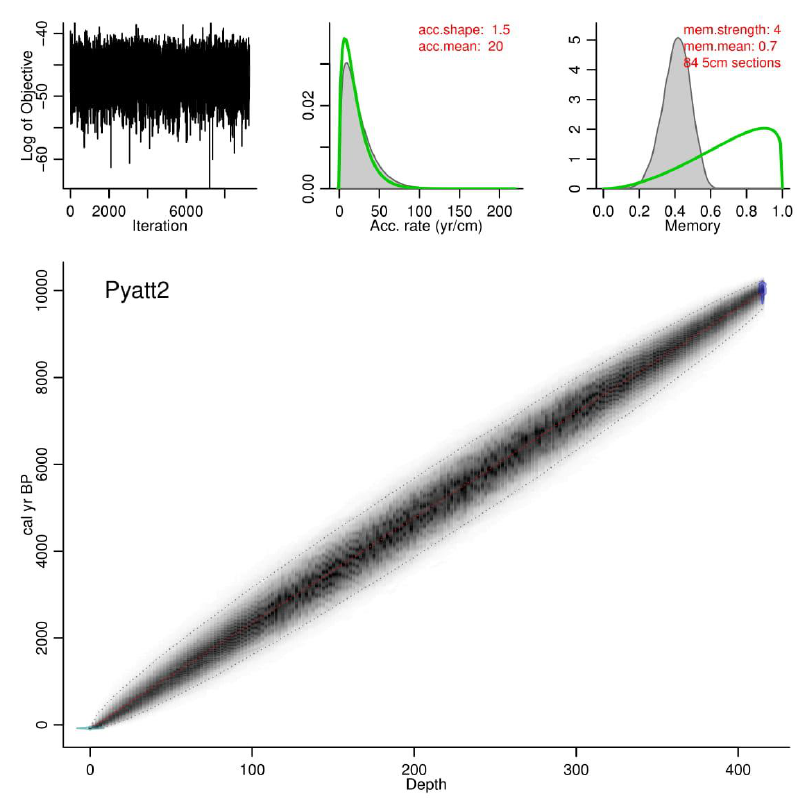
Figure A3l. Age-depth model produced in BACON for